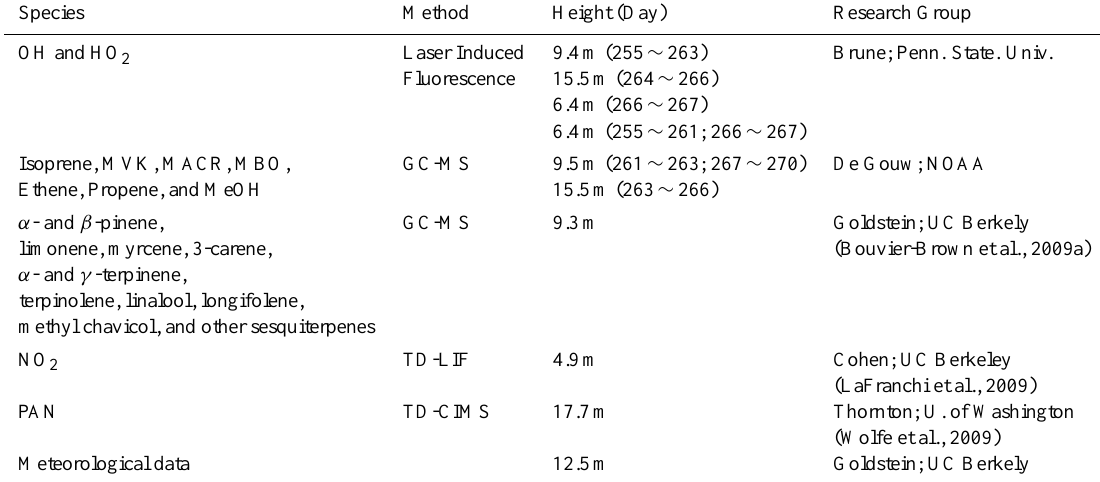
Table 1. Other atmospheric species simultaneously observed in this study and research groups who provided the data.